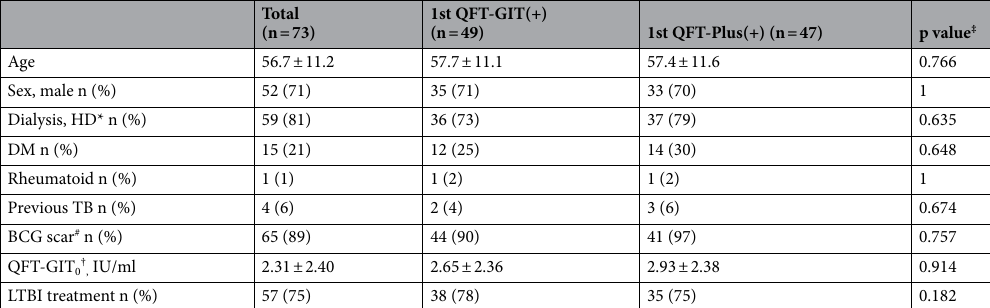
mean ± SD p Spearman